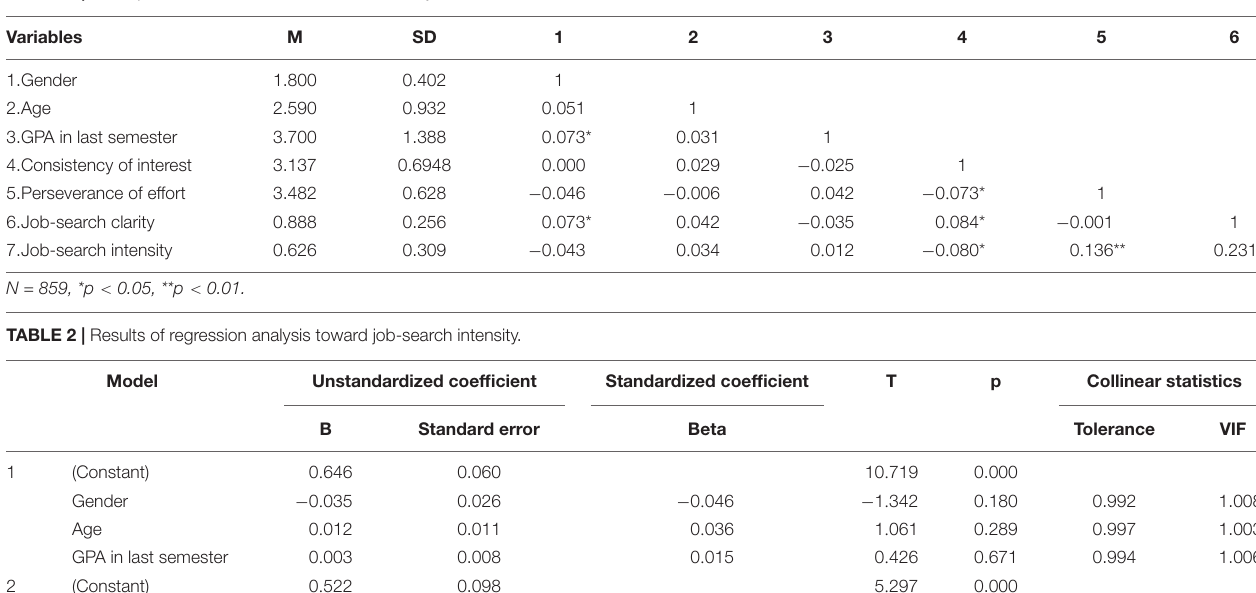
TABLE 1 | Descriptive statistics and correlations of study variables.